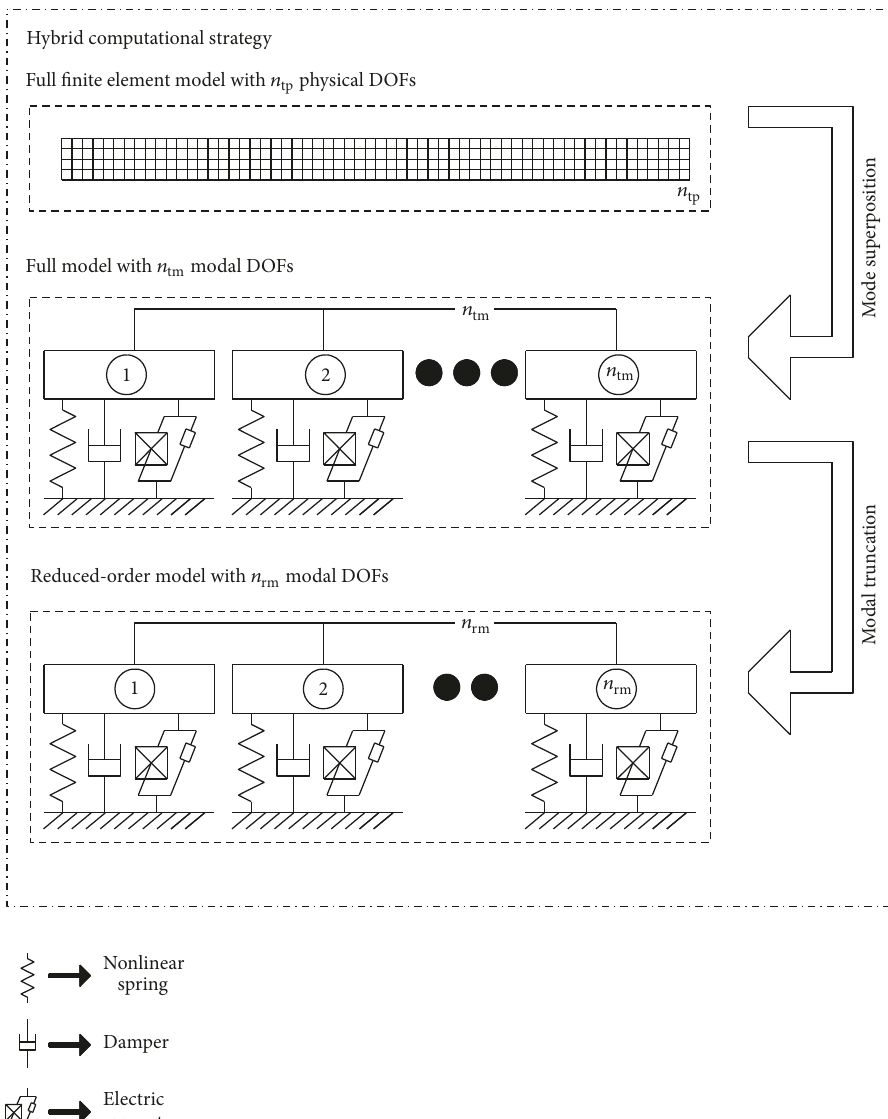
Figure 2: Implemented hybrid computational